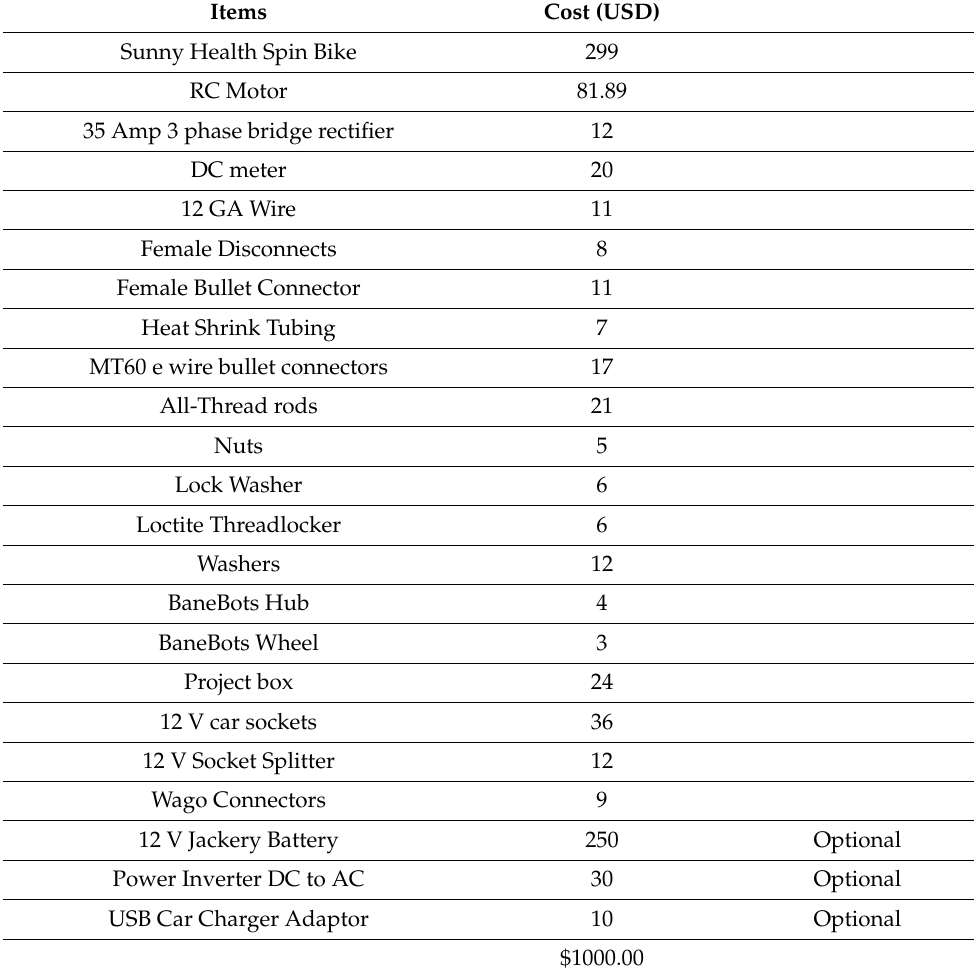
Table 2. Components and cost (including the bike). Items Cost